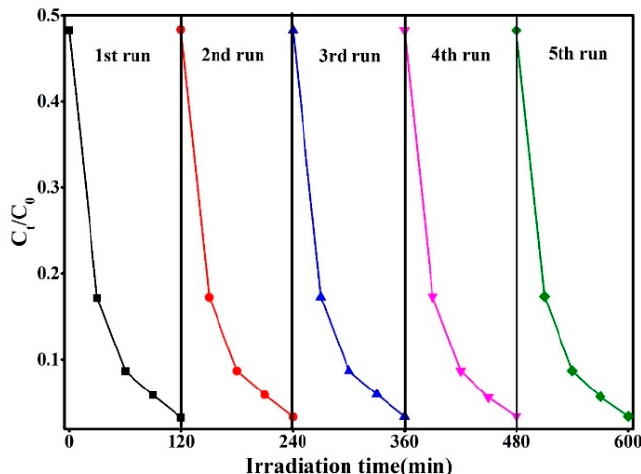
Figure 7. The photocatalytic degradation of RhB over time ( a ); the first-order kinetic curve ( b ) for pure SnS 2 and Ag 2 S@SnS 2 composites.